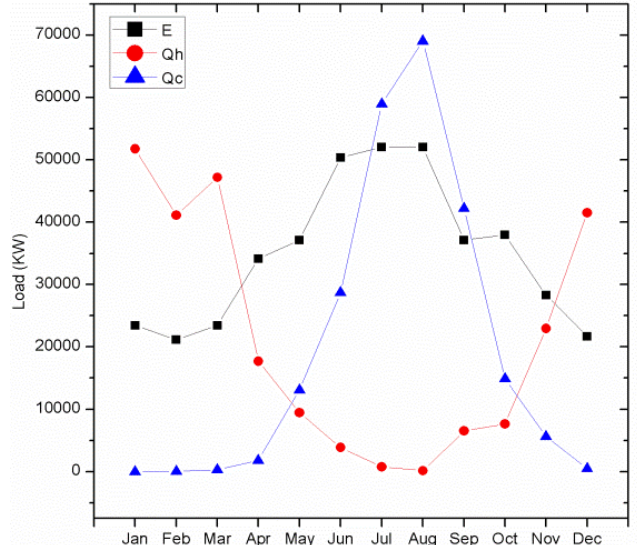
Figure 8. The simulated electric, cooling, and heating loads based on DeST software for the reference building in Dalian,